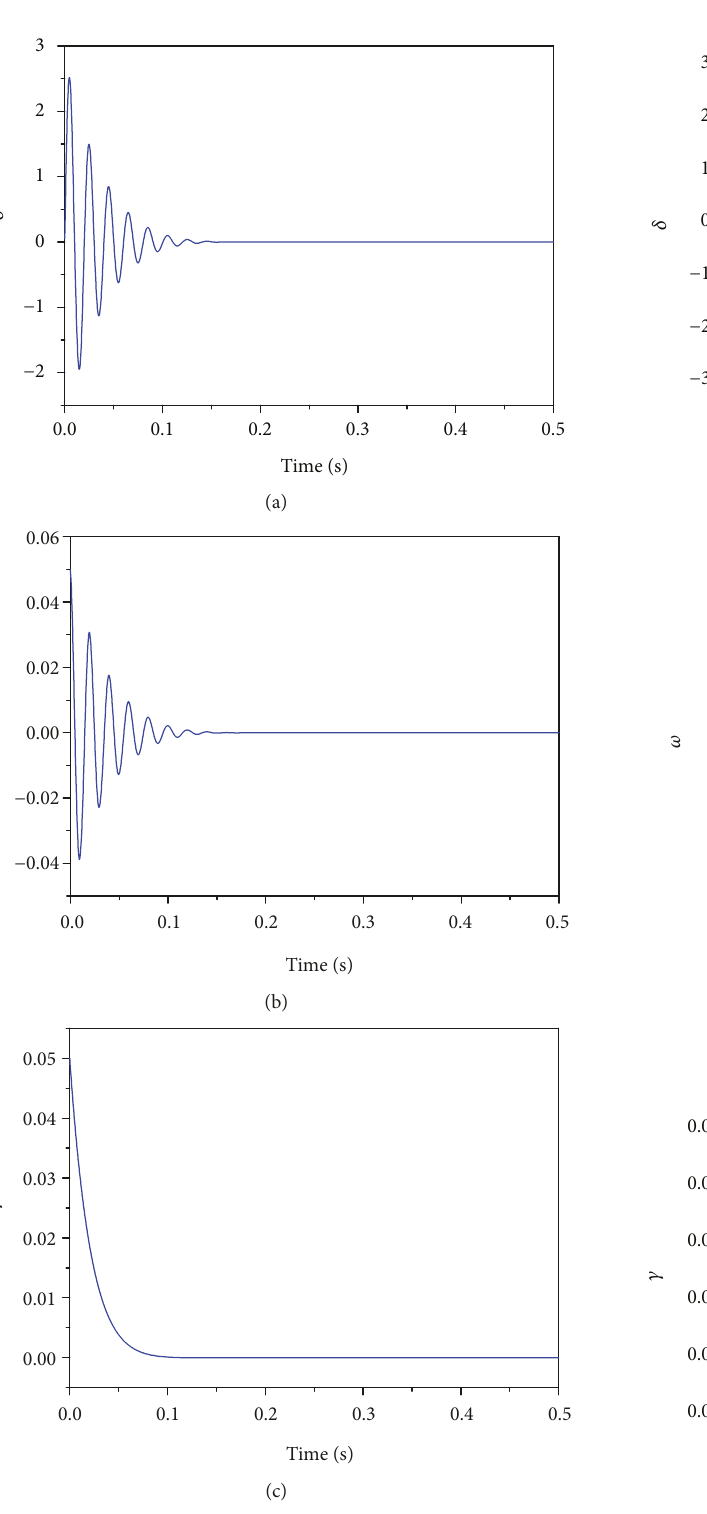
Figure 1: The response of the system variables δ , ω , and y with fi xed-time feedback controllers.